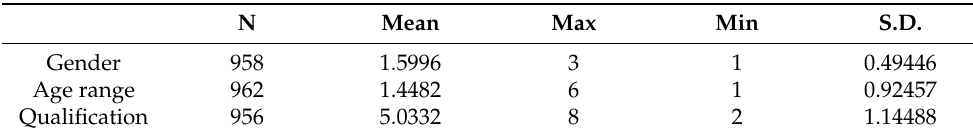
Table 2. Descriptive statistics summary of the